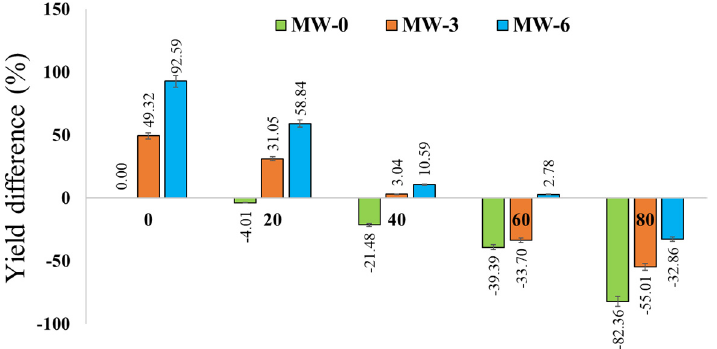
Figure 6. Grain yield difference at different soil arsenic (As) concentration in the microwave (MW) treated soil. The mean values are shown in the bar along with standard error and value of difference. A positive value indicates the increase in yield and a negative value shows a reduction in grain yield.